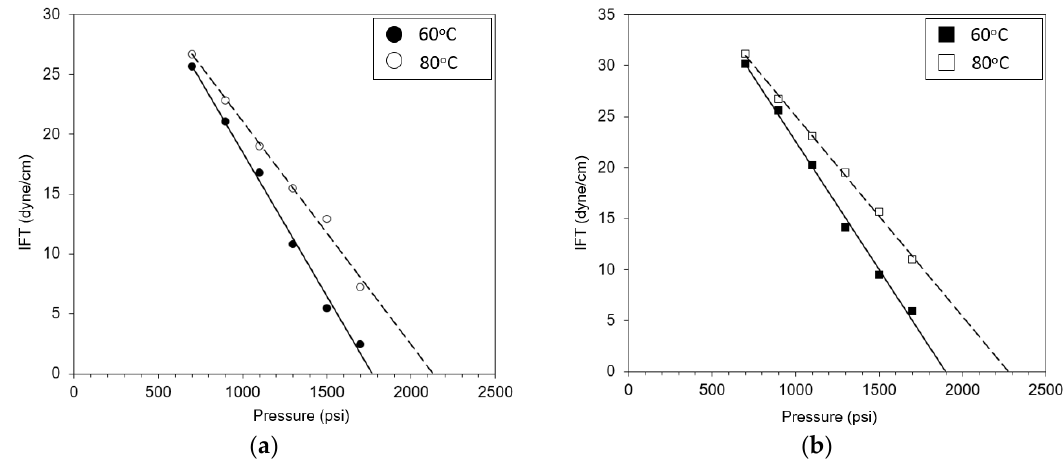
Figure 7. IFT versus CO 2 injection pressure as di ff erent temperatures: ( a ) crude oil A and ( b ) crude oil